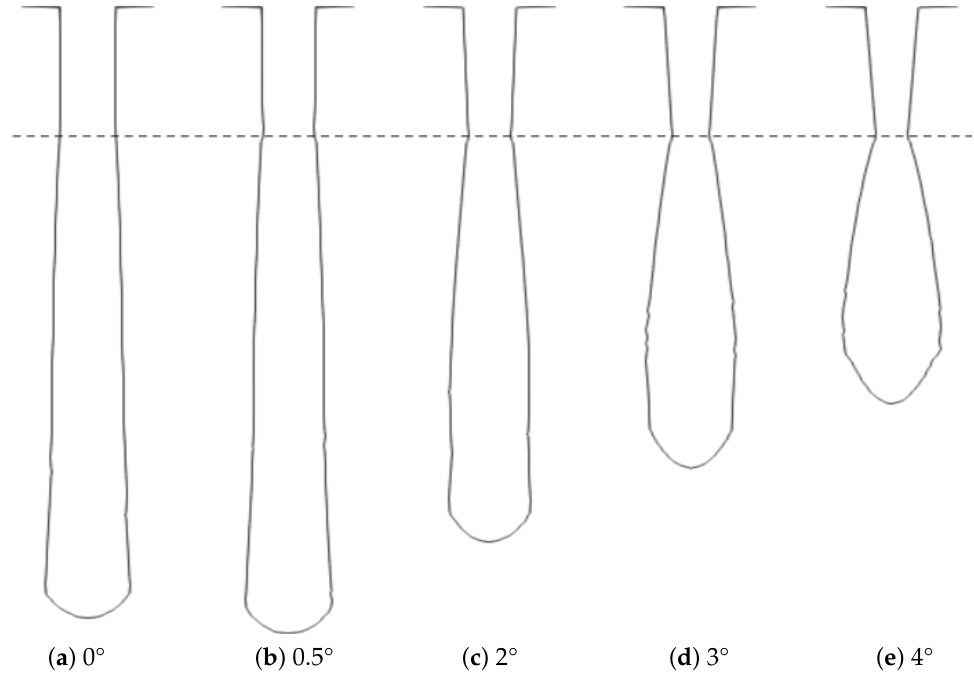
Figure 7. Cross sections of the etched cylindrical holes obtained by varying the mask tapering from perfectly vertical at 0° to 4° for y O = 0.5. Both the increased vertical etch rate with slight tapering 2 and the effects of bowing are